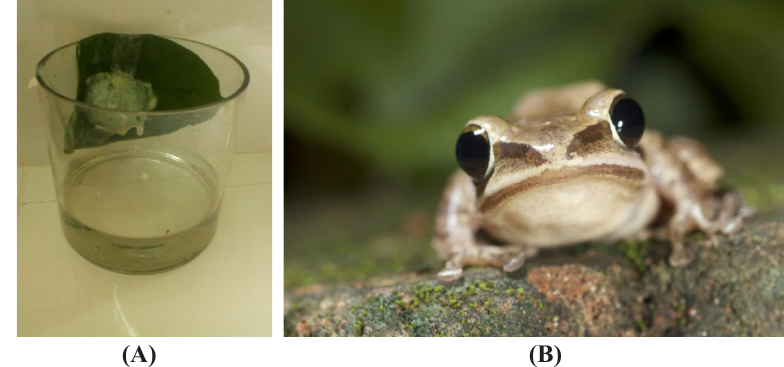
Figure 1: The common hourglass tree frog Polypedates cruciger A) Adult B) Foamy egg mass attached to a